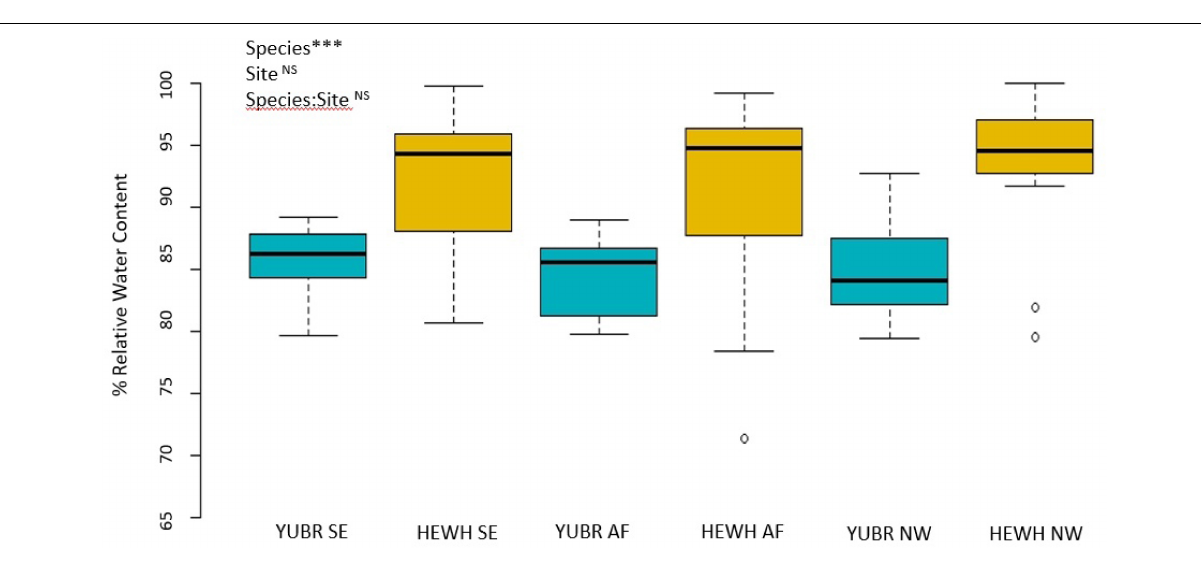
FIGURE 4 | Relative water content (RWC) did not differ across sites. Results from two-way ANOVA are shown in the top left corner. YUBR = Y. brevifolia ; HEWH = H. whipplei ; SE, south-eastern slope; AF, alluvial fan; NW, north-western slope. n = 13–20 leaves per species per site. *** p < 0.001; NS p >